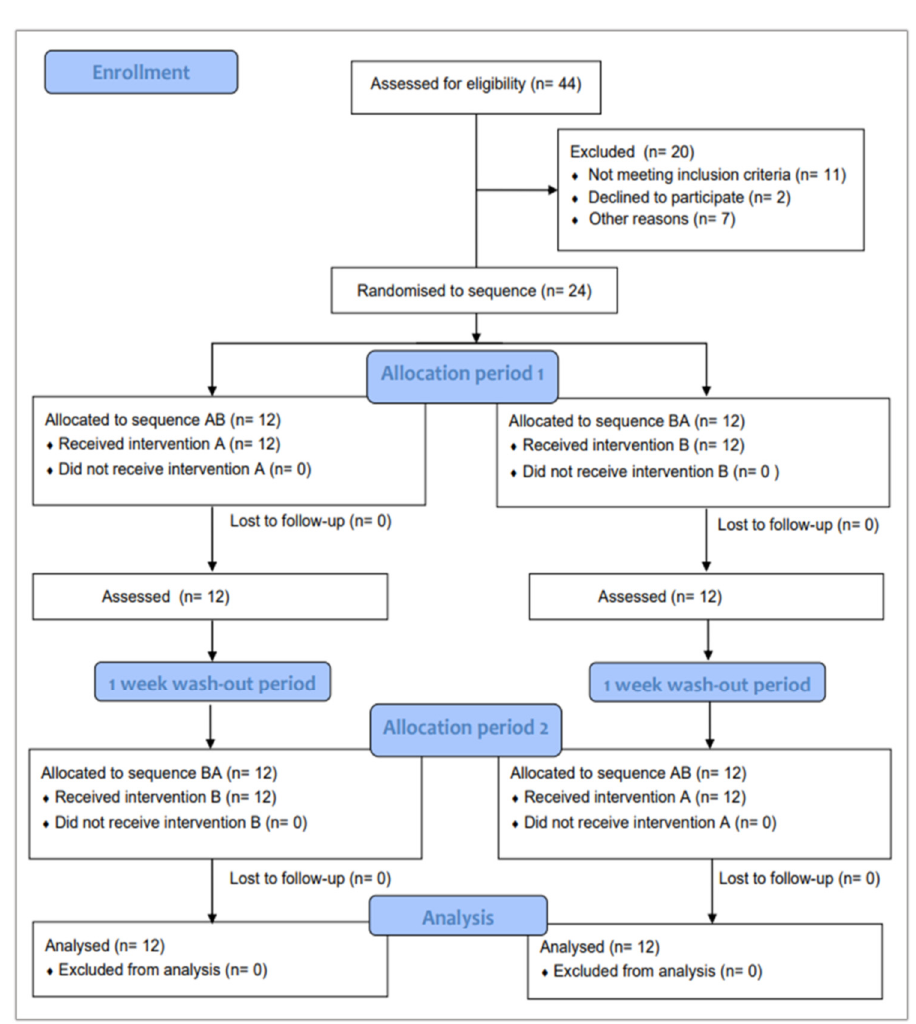
Figure 2. CONSORT flow chart for the crossover trial. A: control toothbrush; B: test toothbrush. Table 1. Demographic variables, tobacco and systemic conditions for subjects in each sequence of use, and for the whole sample.